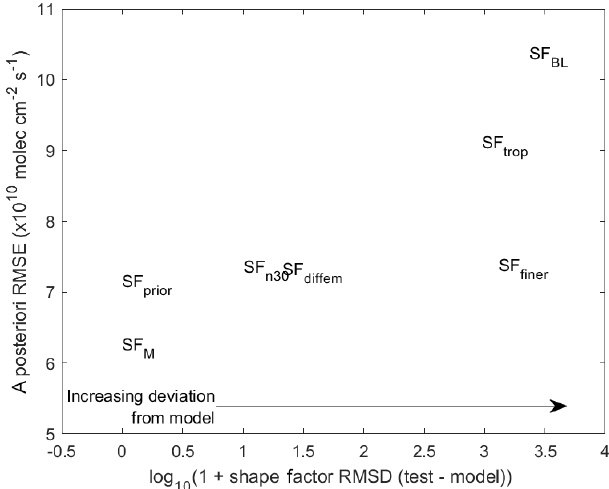
Figure 5. Scatterplot of adjoint test results. X axis represents the deviation of the shape factor from the model-simulated shape fac- tor (root mean square difference). Y axis represents the a posteriori emissions error from the adjoint